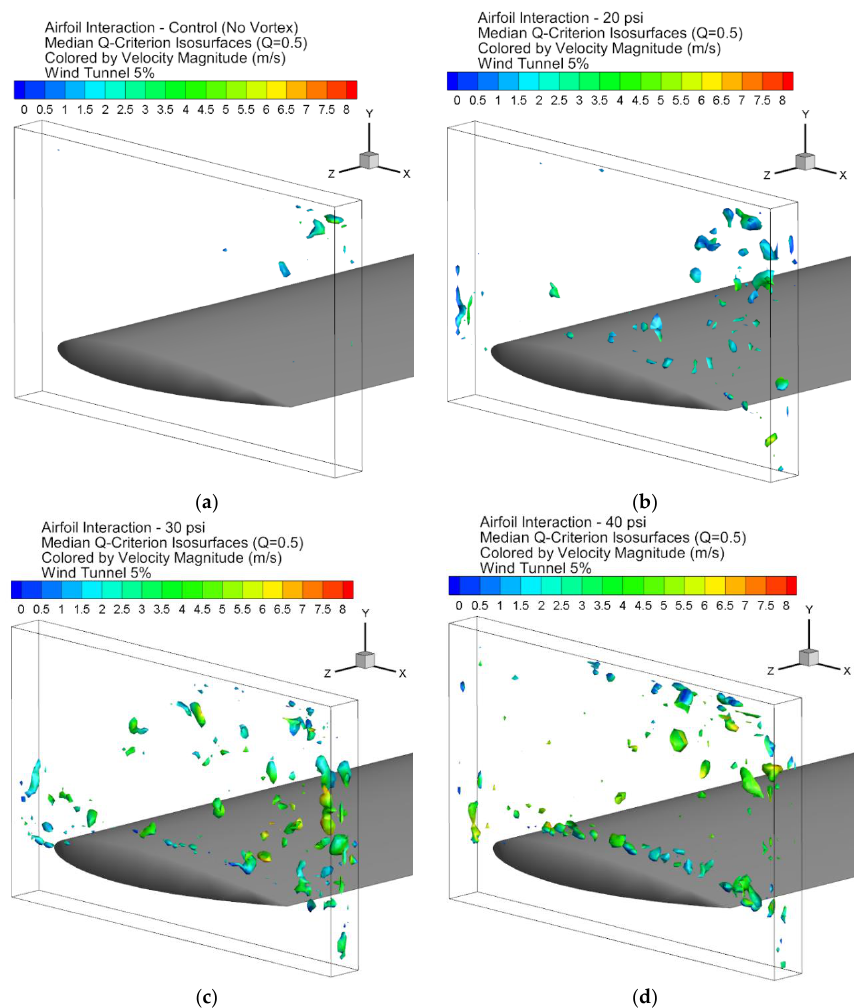
Figure 27. Airfoil interaction with q-criterion isosurfaces: control (no vortex tube) instantaneous median frame ( a ), and with the vortex tube set at 20 psi ( b ), 30 psi ( c ), and 40 psi ( d ).